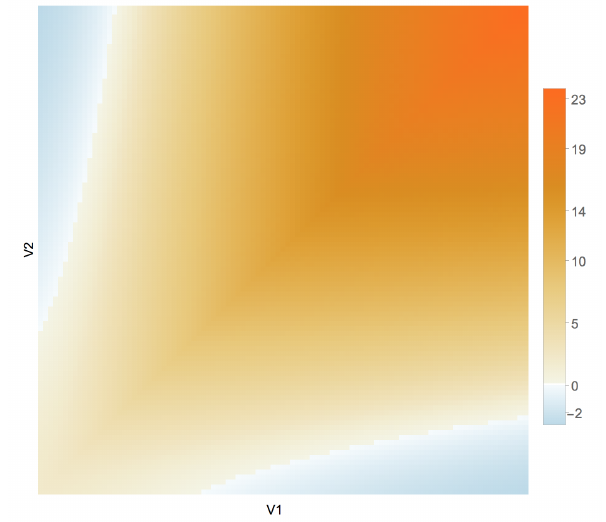
Figure 9: The figure above is a numerical computation which represents the value of the perimeter difference µ ( V 1 , V 2 ) for Borell density f ( x ) = e x 2 . The orange color marks the region in which the double interval has lesser perimeter, the blue color represents the region in which the triple interval has lesser perimeter, and the white curve marks the tie point between the double and triple intervals. Computed in